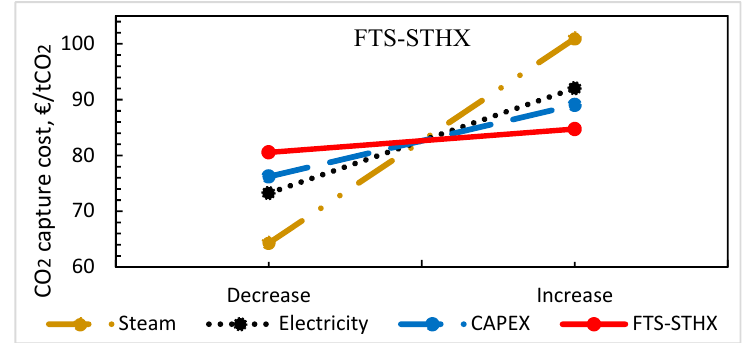
Figure 10. Sensitivity of important economic variables on the capture cost of the FTS-STHX case.